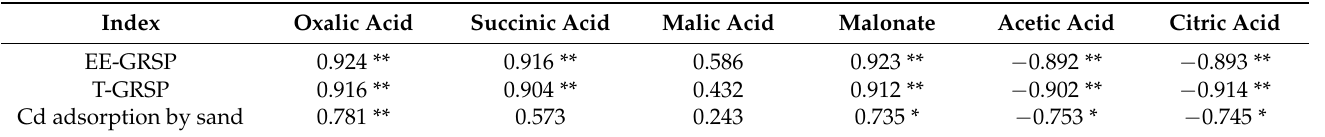
Table 5. Correlation between root secretion of low-molecular-weight organic acids and GRSP and quartz sand Cd